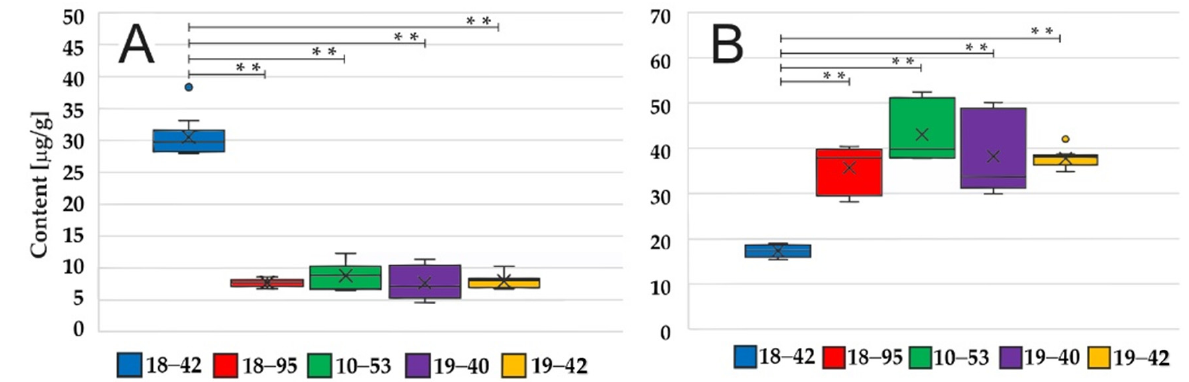
Figure 2. ( A ) Hydroxyferricrocin and ( B ) ferricrocin in A. fumigatus pellets. The VF A. fumigatus has higher HFC but lower FC content as compared to the VI strains at 52 h, n = 9. Asterisks (**) indicate statistical significance (Kruskal–Wallis, p <